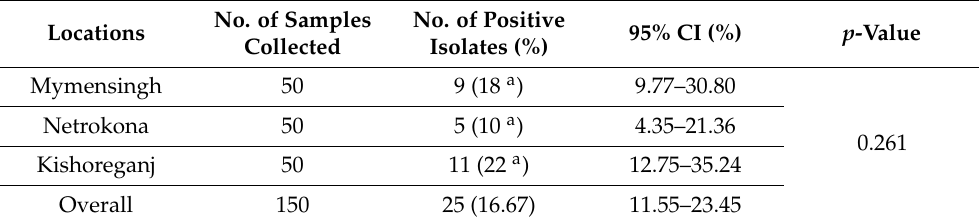
Table 1. Prevalenceof C.freundii isolatedfromcloacalswabsofducksfromdifferentdistrictsofBangladesh.